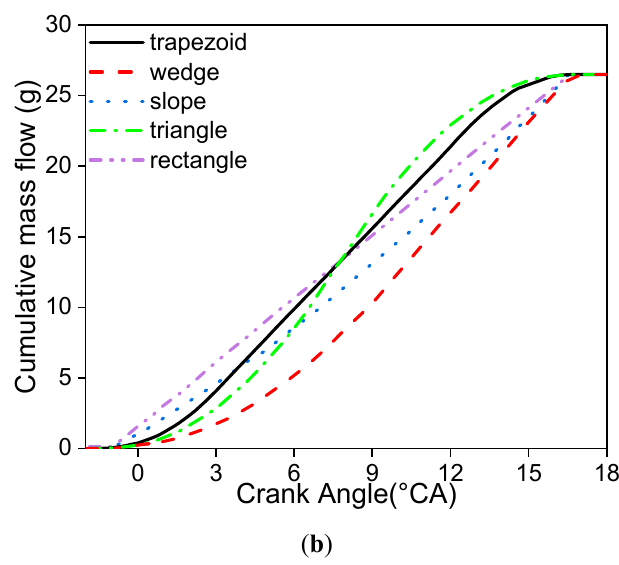
Figure 3. Five different gas injection rate shapes ( a ) and their corresponding cumulative flow ( b ).